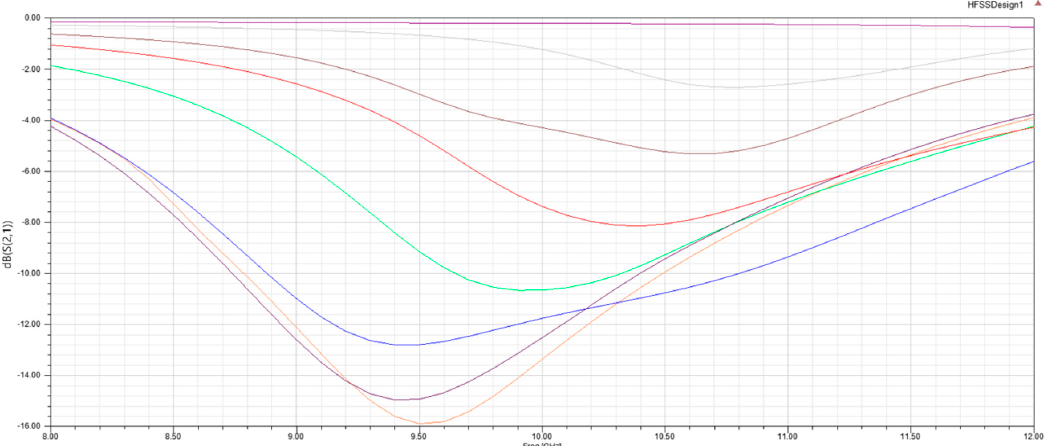
Figure 12. The equalization curves over the 8–12 GHz band realized by adding the single curves of each resonator.